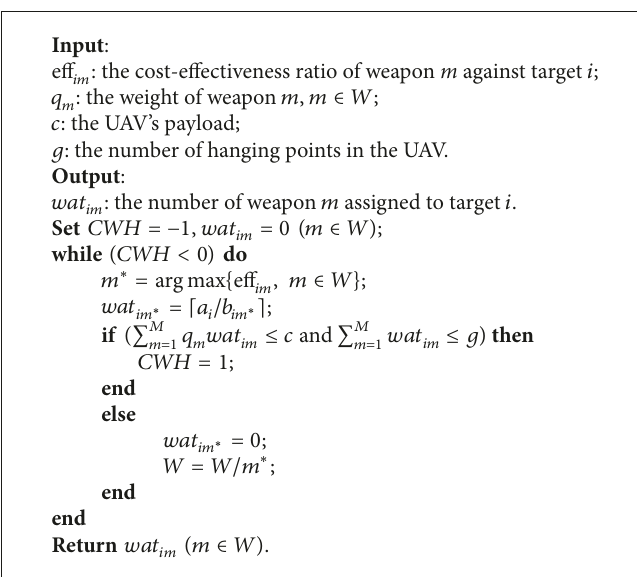
Algorithm 3: Procedure of the assigning strategy based on